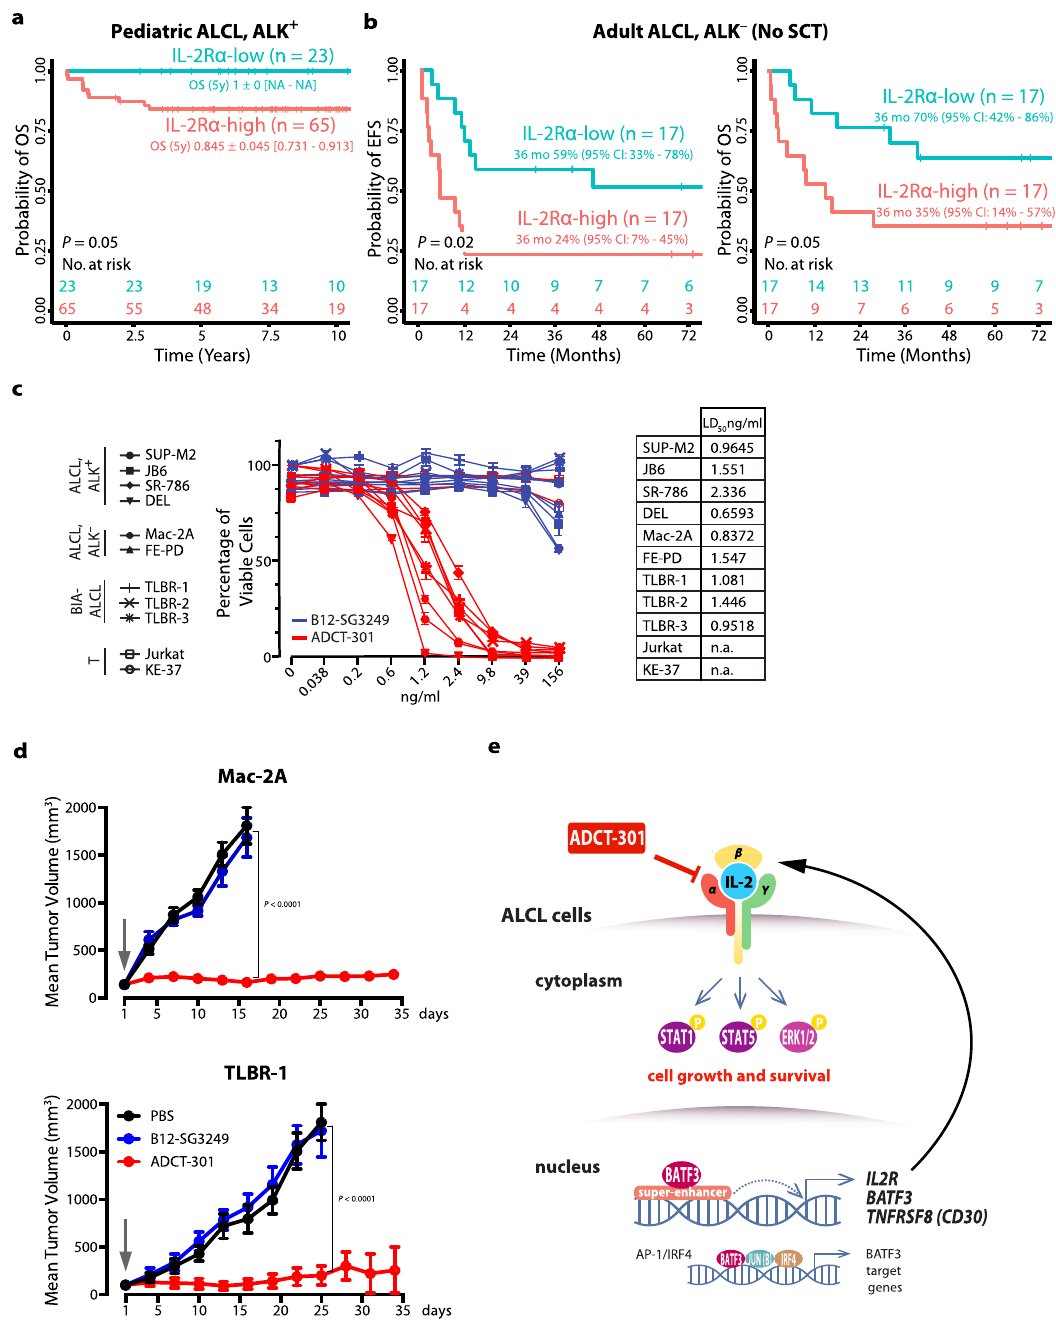
Fig. 4 IL-2R α expression in ALCL patients correlates with survival and represents potential therapeutic target. a OS of pediatric ALCL, ALK + patients (NHL-BFM cohort, n = 88), and b EFS and OS of adult ALCL, ALK − patients without SCT ( n = 34) having low (staining intensity, SI = 0 – 2) or high (SI = 3) IL-2R α expression. Kaplan – Meier curves of individual groups were compared using two-tailed log-rank statistics. c Indicated 9 ALCL cell lines and 2 T-cell leukemia-derived control cell lines were incubated for 96 h with different concentrations of PDB dimer linked antibodies targeting either IL-2R α (ADCT-301) or, as a non-binding control, the glycoprotein gp120 of HIV (B12-SG3249) to determine the LD 50 . Means ± SD of biological triplicates are shown. d In vivo anti-tumor ef fi cacy of ADCT-301 in murine xenograft models of Mac-2A (ALK − ) or TLBR-1 (BIA) ALCL cell lines. For each cell line, mice were randomized into three groups to receive a single dose of either vehicle (PBS, n = 4), control ADC (B12-SG3249, 0.5 mg/kg, n = 5), or ADCT-301 (0.5 mg/kg, n = 5) intravenously at day 1 (indicated by an arrow). Tumor volumes were measured with caliper over time and are shown as means ± SEM. P values were determined by two-tailed unpaired Student ’ s t test. e Schematic illustration of the proposed the ALCL hallmark-gene CD30 . Whether IL-2R and CD30 are interconnected and IL-2R-signaling substitutes for the loss of TCR-signaling in ALCL 15,16 has to be determined in future studies.